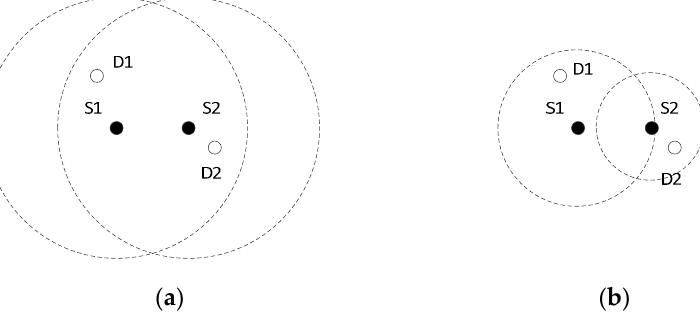
Figure 2. An example of creating a space domain parallel transmission opportunity by power control. ( a ) transmit with normal power; ( b ) transmit with reduced power.